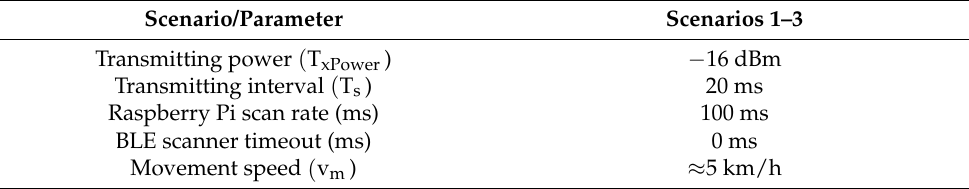
Table 6. Parameter settings for scenarios